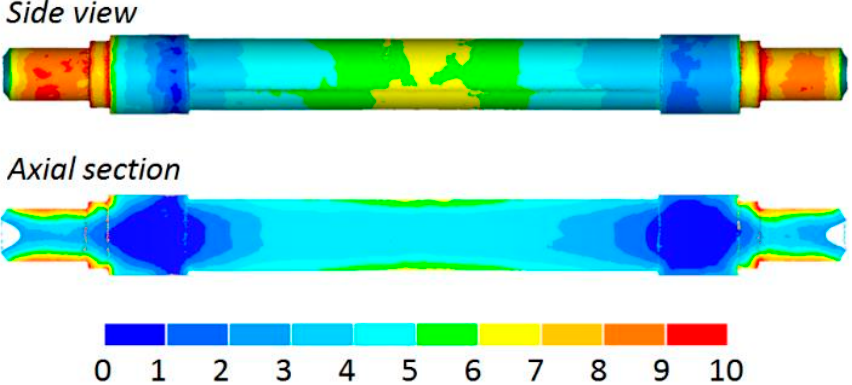
Figure 8. Distribution of effective strains in a rail axle produced by two-stage CWR [9] (Reprinted from ref. [9]).